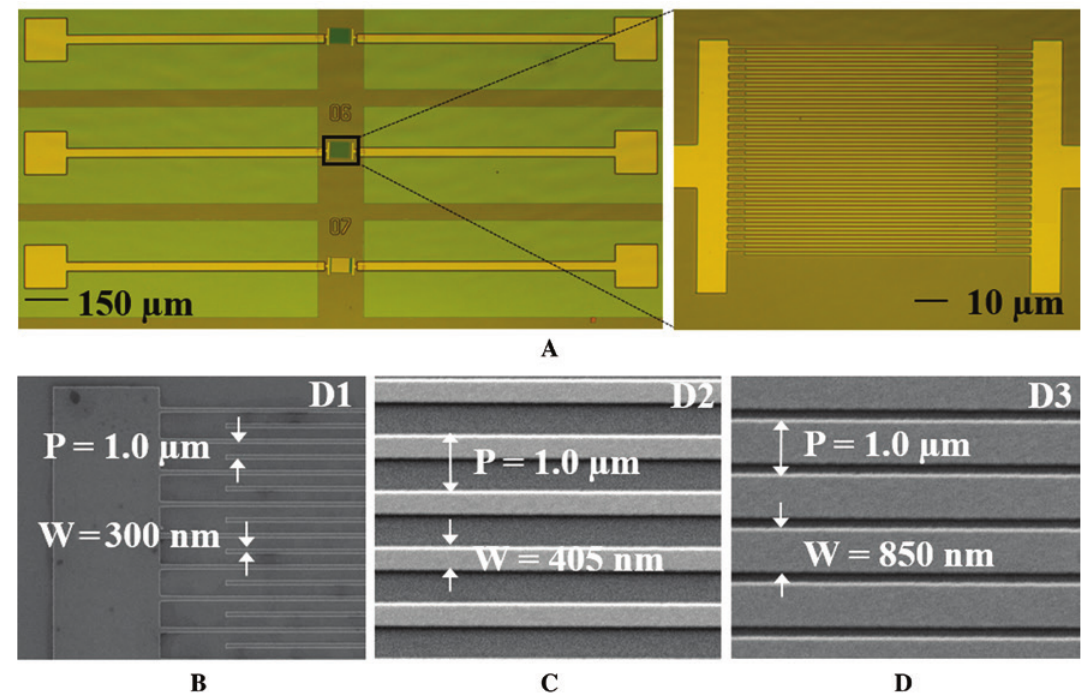
Figure 2: Fabricated metafilm absorbers. (A) The optical microscope images of the fabricated metafilm absorbers. (B–D) Close up scanning electron microscope images of the devices with metal rod widths of 300, 405 and 850 nm.